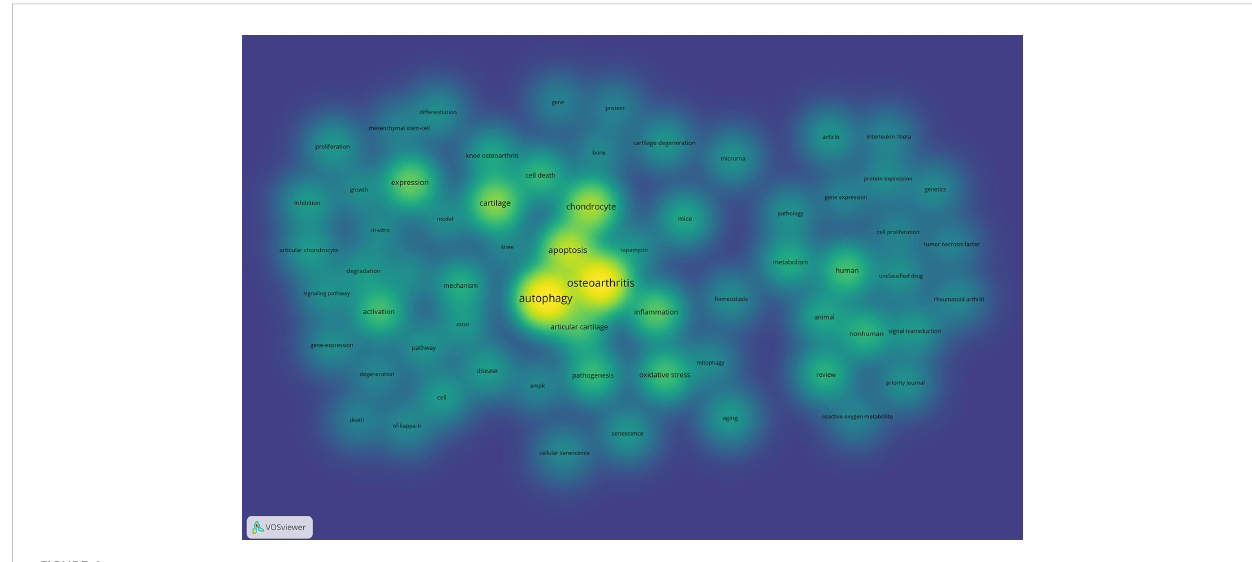
FIGURE 4 Density map of keywords related to autophagy in OA from: VOSviewer.